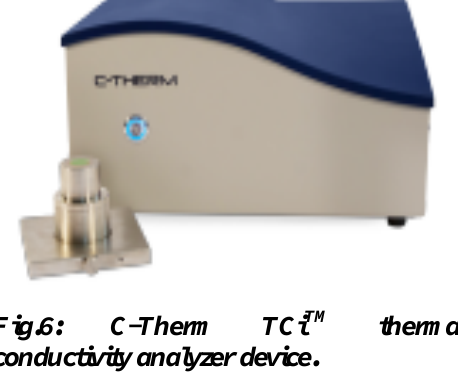
Fig.6: conductivity analyzer